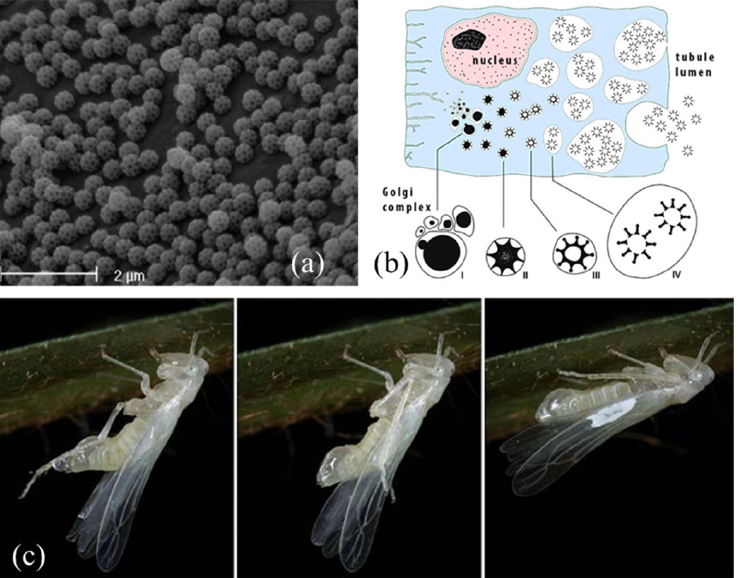
Figure 5. ( a ) Integumental brochosomes. Image courtesy of Andrea Lucchi, Department of Agriculture, Food and Environment, University of Pisa, Italy. ( b ) Development of brochosomes through four stages in Golgi-derived vesicles. Image credit: Roman Rakitov, licence CC BY-SA 4.0. ©2016 https://www.wikiwand.com/en/Brochosome#Media/File:Brochosome_secretion_En.jpg. ( c ) A freshly molted female of Igutettix oculatus (Lindberg, 1929) using hind tibiae to transfer the fluid medium containing brochosomes from the anus (Left) onto the forewings (Center) where it dries in white spots (Right). Images credit: Roman Rakitov, CC BY-SA 3.0. ©2009 https://www.wikiwand.com/en/Brochosome#Media/File:Igutettix_anointing.jpg.